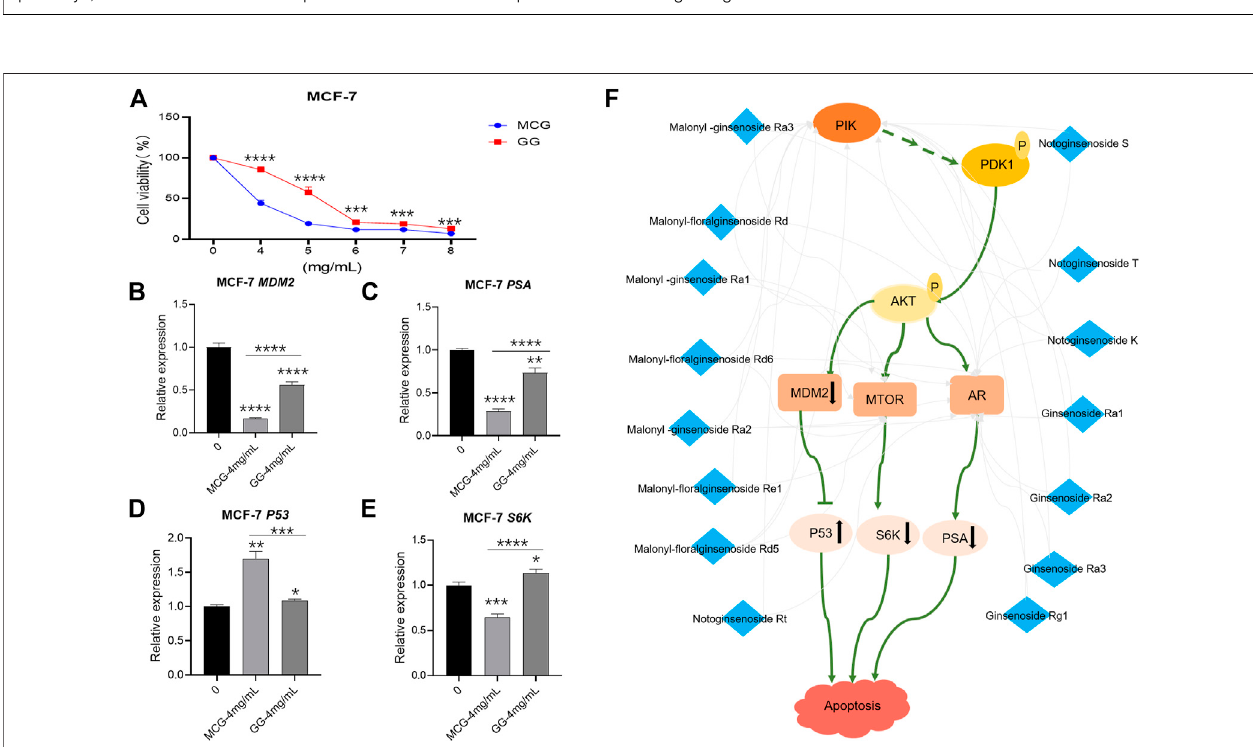
FIGURE 6 | In vitro pharmacodynamics experiments and RT-PCR detection of key effector genes in MCG and GG. (A) : Results of in vitro pharmacodynamics experiments ofMCG and GG. (B – F) : Results of RT-PCR detection ofkey effector genesin MCG and GG. “ * ” : p < 0.05; “ ** ” : p < 0.01; “ *** ” : p < 0.001; “ **** ” : p < 0.0001. (F) :Mechanism of anti-breast cancer effect of quality markers of MCG.